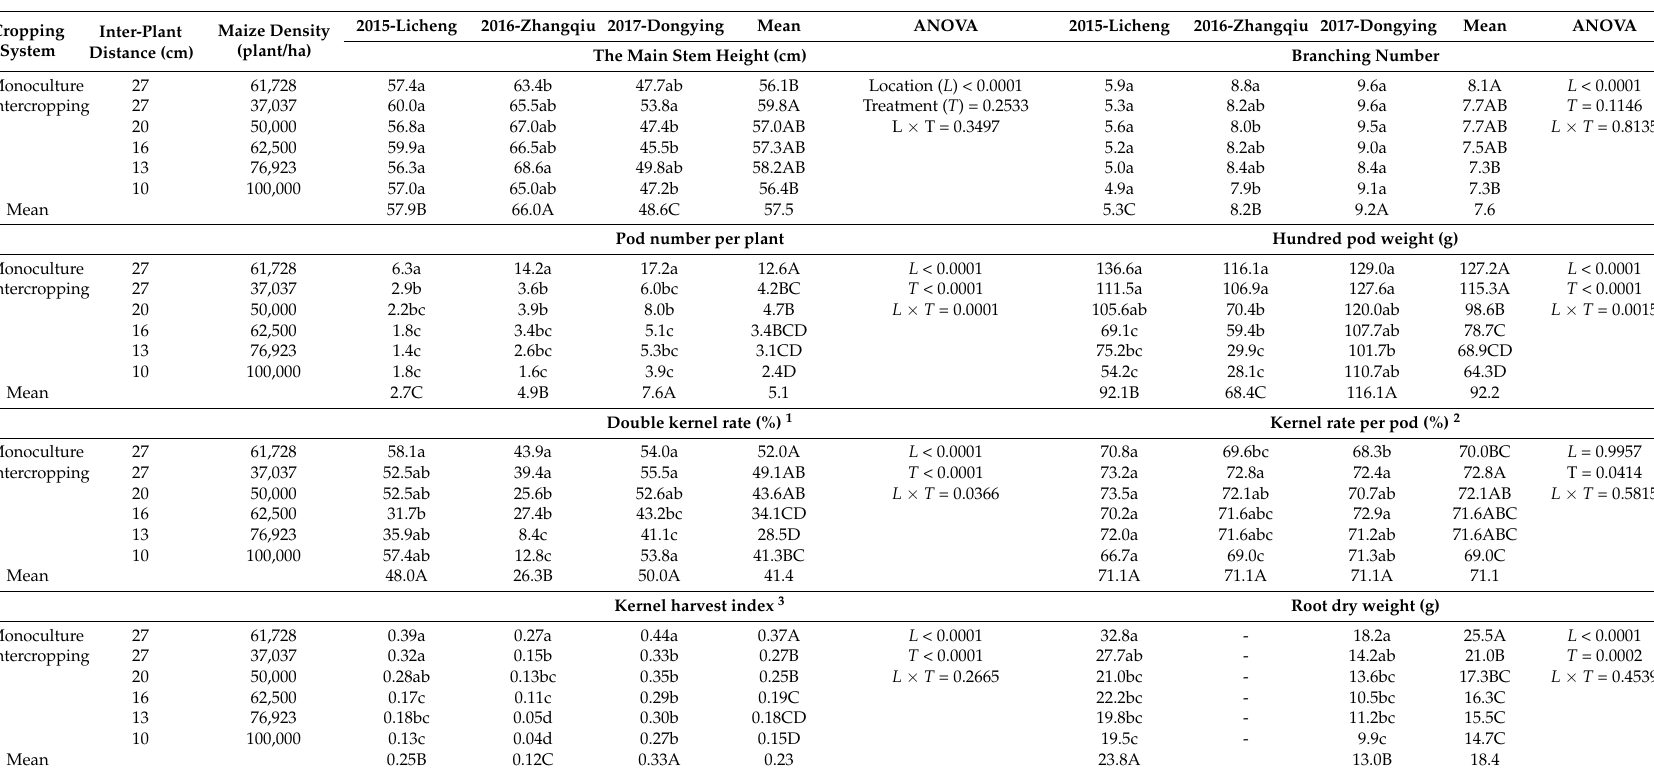
Table 6. Peanut plant, pod and root traits (harvesting two adjacent rows in 1.0 m length in Licheng and Zhangqiu, and 10 plants in Dongying) as affected by different cropping systems and maize densities across different